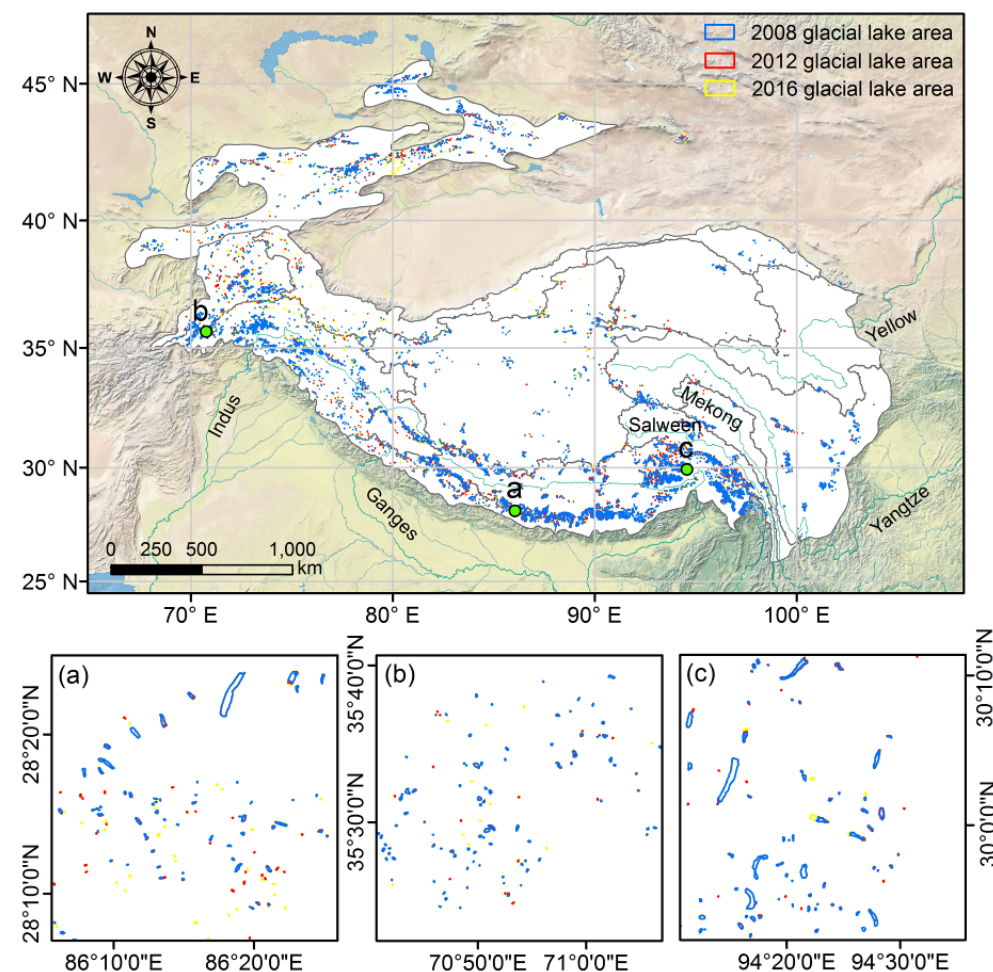
Figure 4. Distribution of glacial lakes in the HMA in 2008, 2012, and 2016. This map was produced using an automated mapping method and Landsat images collected throughout the year. The three zoom-in maps ( a – c ) show local detail in different regions including the central Himalaya ( a ), Eastern Hindu Kush ( b ), and Nyainqentanglha ( c ).